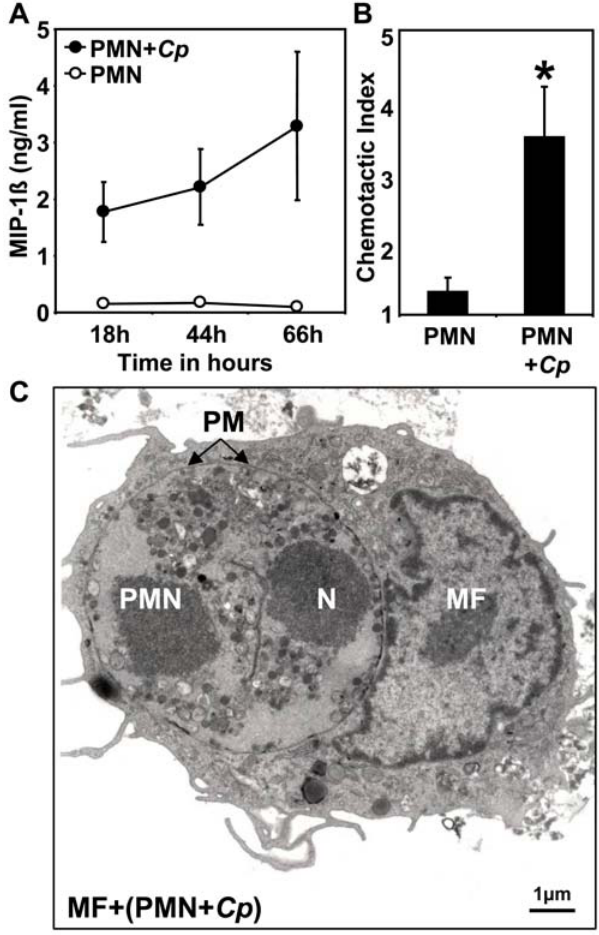
Figure 3. Increased MIP-1ß release in C.pneumoniae infected PMN. PMN were infected with C. pneumoniae (closed circles) or mock infected with HEp-2 lysates (open circles) ( A ). Increased secretion of MIP-1ß was observed in the supernatants of C. pneumoniae - infected PMN at the given time points by ELISA ( A ). The chemotactic index (specific migration/migration towards medium) indicates that mono- cytes are significantly better attracted by supernatants taken from C. pneumoniae - infected PMN than mock- infected control cells ( B , p=0.04; n=3). Using transmission electron microscopy we could show that C. pneumoniae - infected PMN are engulfed by monocyte- derived macrophages ( C ). Arrows indicate the phagosomal membrane (PM) of the macrophage; containing a complete apoptotic PMN with con- densed nucleus (N) (bar equals 1 m m, magnification 6000 6 ).